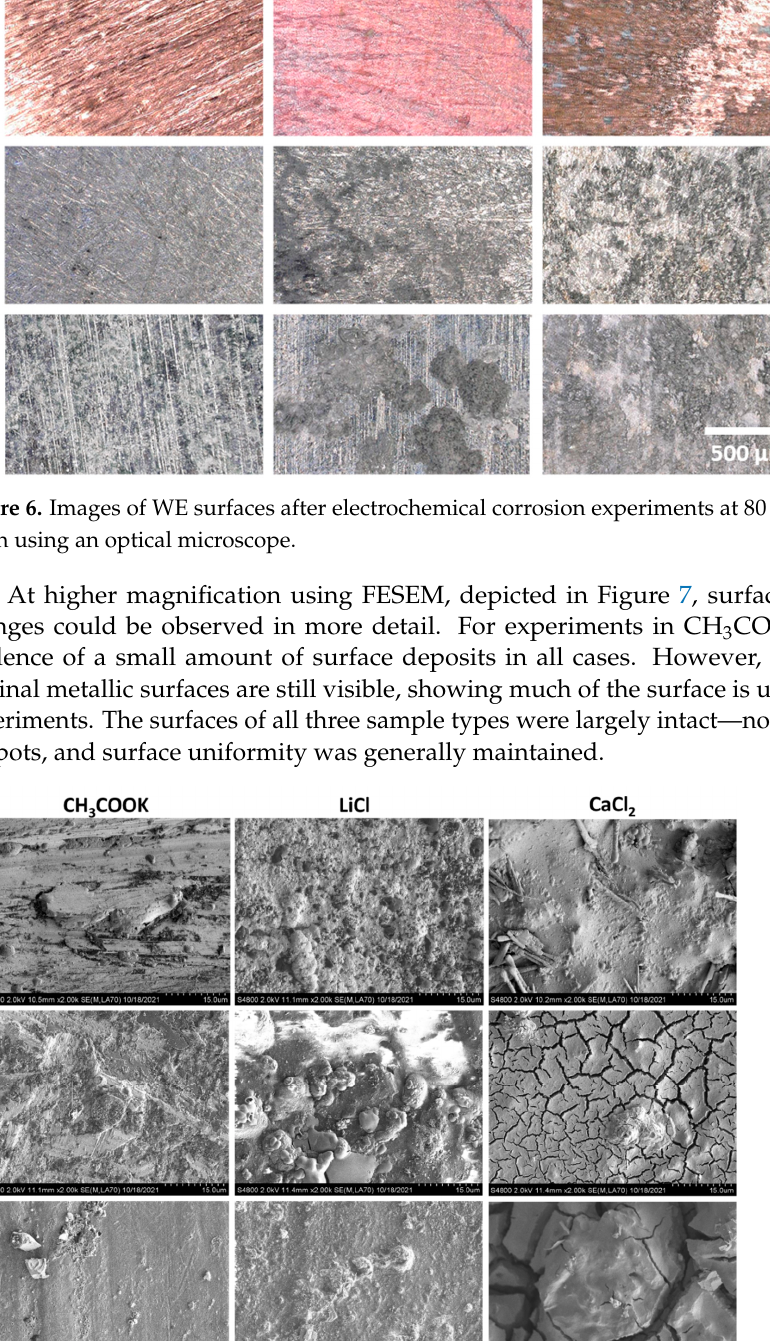
10 of 20 Figure 5. Examples of potentiodynamic polarization curves used to evaluate corrosion behavior of metal alloy samples in various liquid desiccants. Data shown is for experiments at 80 °C. Furthermore, Figure 5 shows a possible transpassivation behavior—pitting corro- sion—for both Al3003 and Al1100 samples in LiCl solution above − 0.3 V. For both Al al- loys, the anodic Tafel lines exhibit an inverse relationship between current and applied potential between 0.1 V and 0.5 V above OCP, indicating possible passivation, strength- ening with increased potential. At greater than 0.5 V above OCP, the current begins to sharply increase with applied potential, indicating that transpassivation and pitting cor- rosion may be occurring. Such behavior has been well documented in chloride salts. Oxide layers are not stable in the presence of chloride ions which can attack and degrade them [21,33,34]. This results